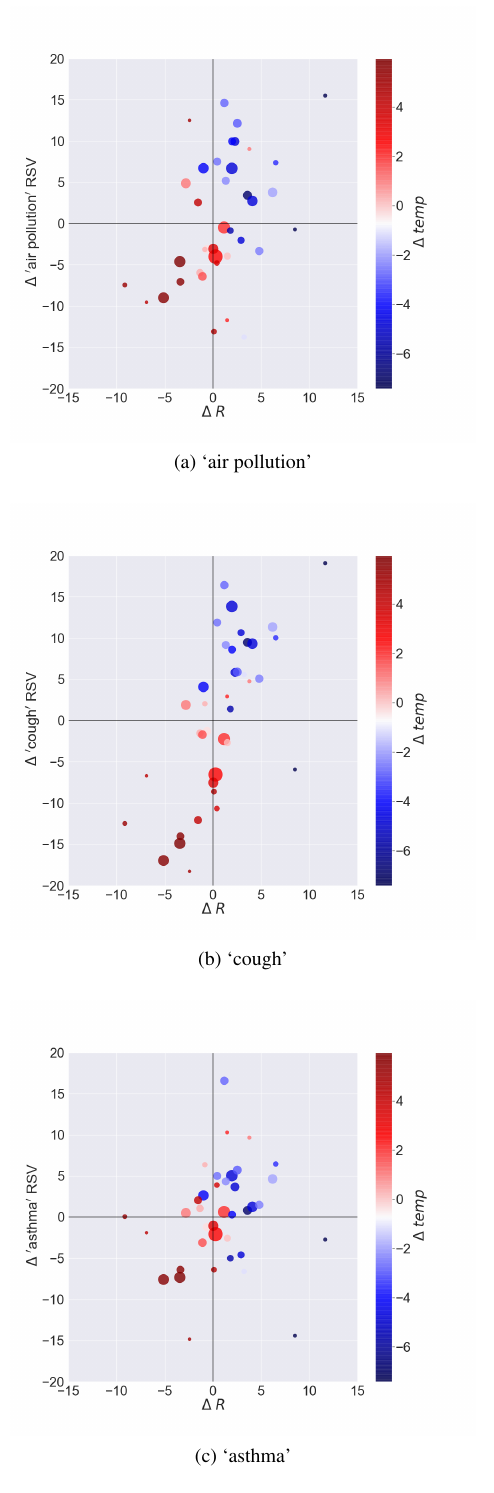
Figure 4. Plot of mean cluster values based on difference from baseline of concentration indicator ( ∆ R ) and temperature Figure 5. Mean sensitivity of the change in (a) ‘air pollution’, ( ∆ temp ) showing difference from mean relative search volume (b) ‘cough’ and (c) ‘asthma’ ∆ (cid:48) RSV with respect to change in ( ∆ RSV ) values of (a) ‘air pollution’, (b) ‘cough’ and (c) AirRGB ∆ (cid:48) R for the 7 mega cities. s 1 and s 2 refer to sensitivity ‘asthma’. Generally positive ∆ R and negative ∆ temp leads to for the period of 1 and 2 weeks while sw 1 and sw 2 refer to their positive ∆ RSV of ‘air pollution’, ‘cough’ and ‘asthma’. Bubble respective weighted size represents relative cluster size.